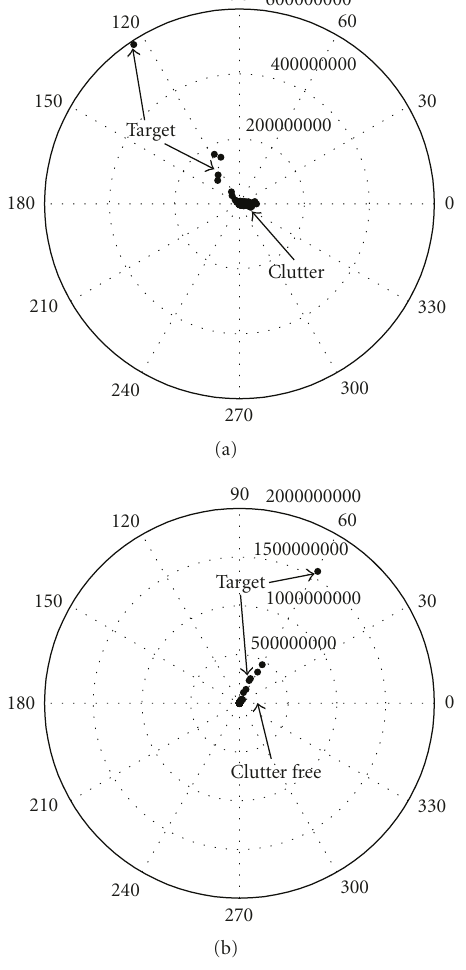
Figure 10: Comparison of (a) the clutter-contaminated inter- ferogram (from channels 1 and 3) and (b) the clutter-canceled interferogram for a detected target (“T1093”) from Figure 9. The baseline between channels 1 and 3 is 3.75 m, twice that of the MODEX-2 mode; therefore, the phase of (a) is roughly twice that of